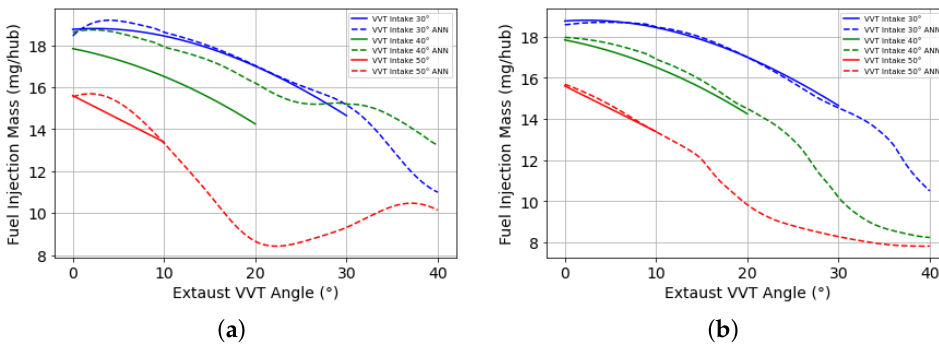
Figure 14. ANN’s extrapolation capacity of the fuel injection as function of exhaust VVT angle in steps of 1° ( a ) using Levenberg–Marquardt backpropagation and ( b ) using Bayesian regulariza- tion